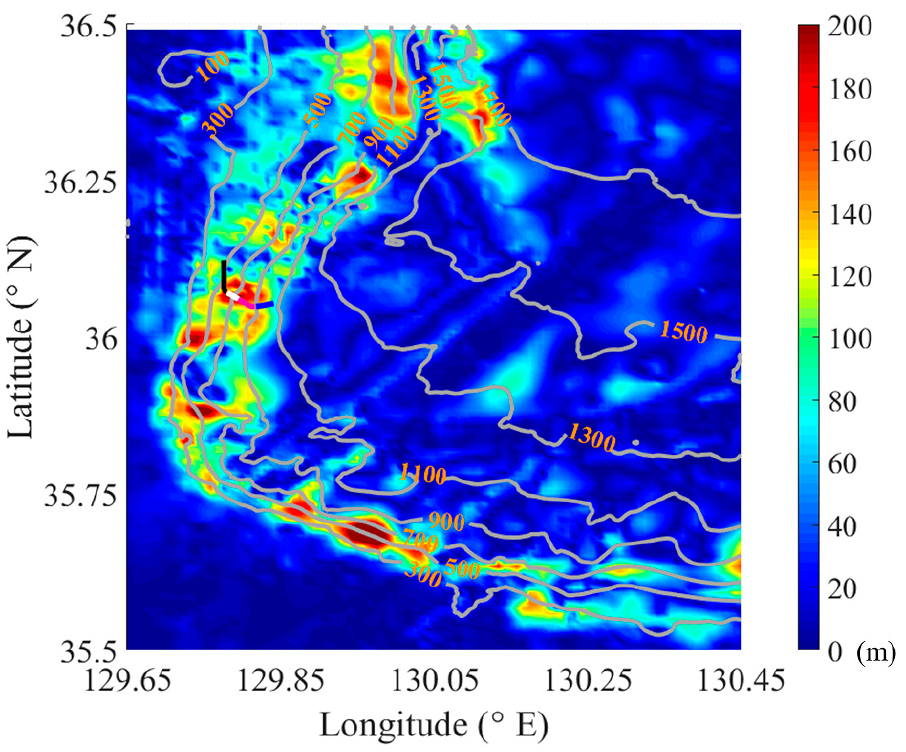
Figure 15. Absolute difference of two bathymetry contours, overlaid by the bathymetry contour using the GEBCO 2020. The thick solid lines represent the route of the R/V vessel corresponding to ping 1~163 and the unit of the contour labels is meters.